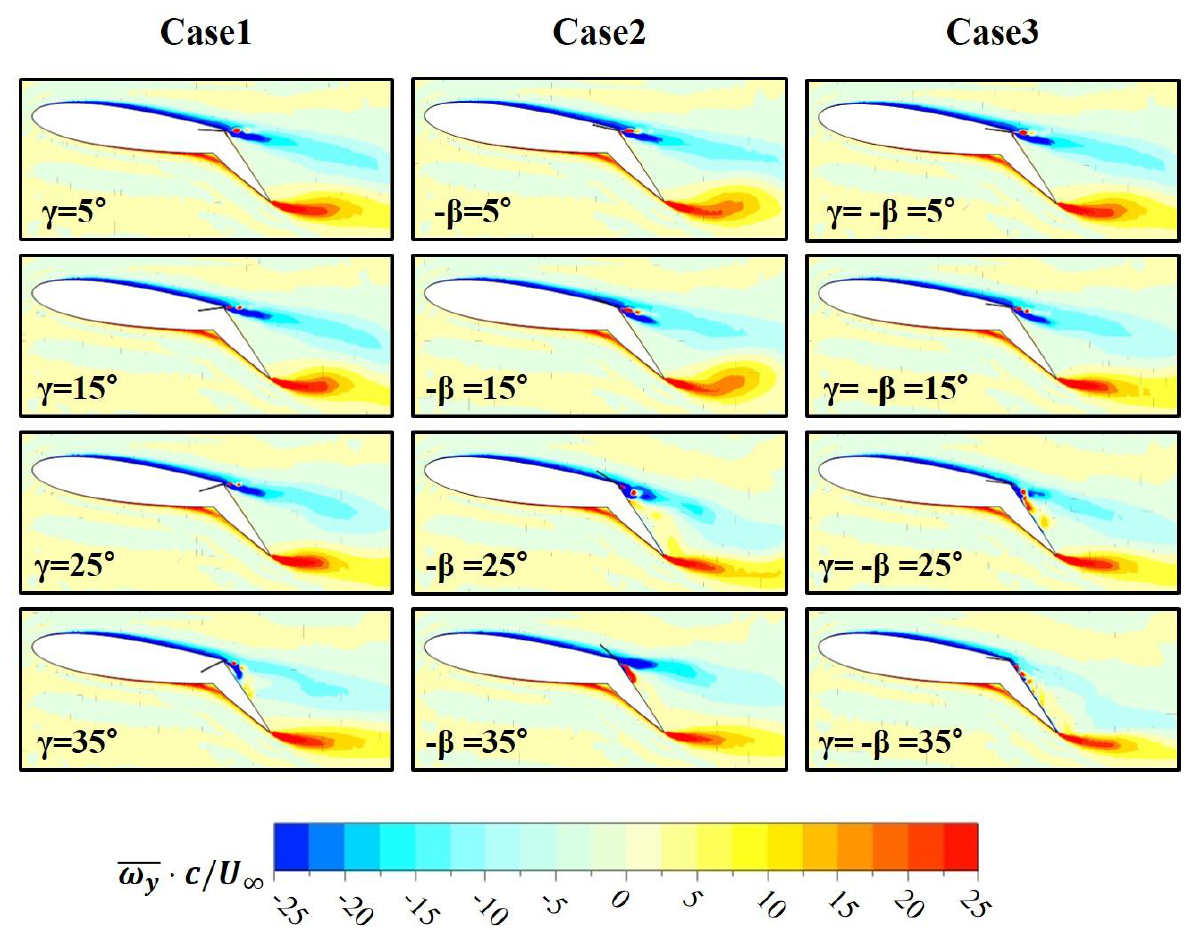
Figure 13. Time-averaged spanwise vorticity contours.